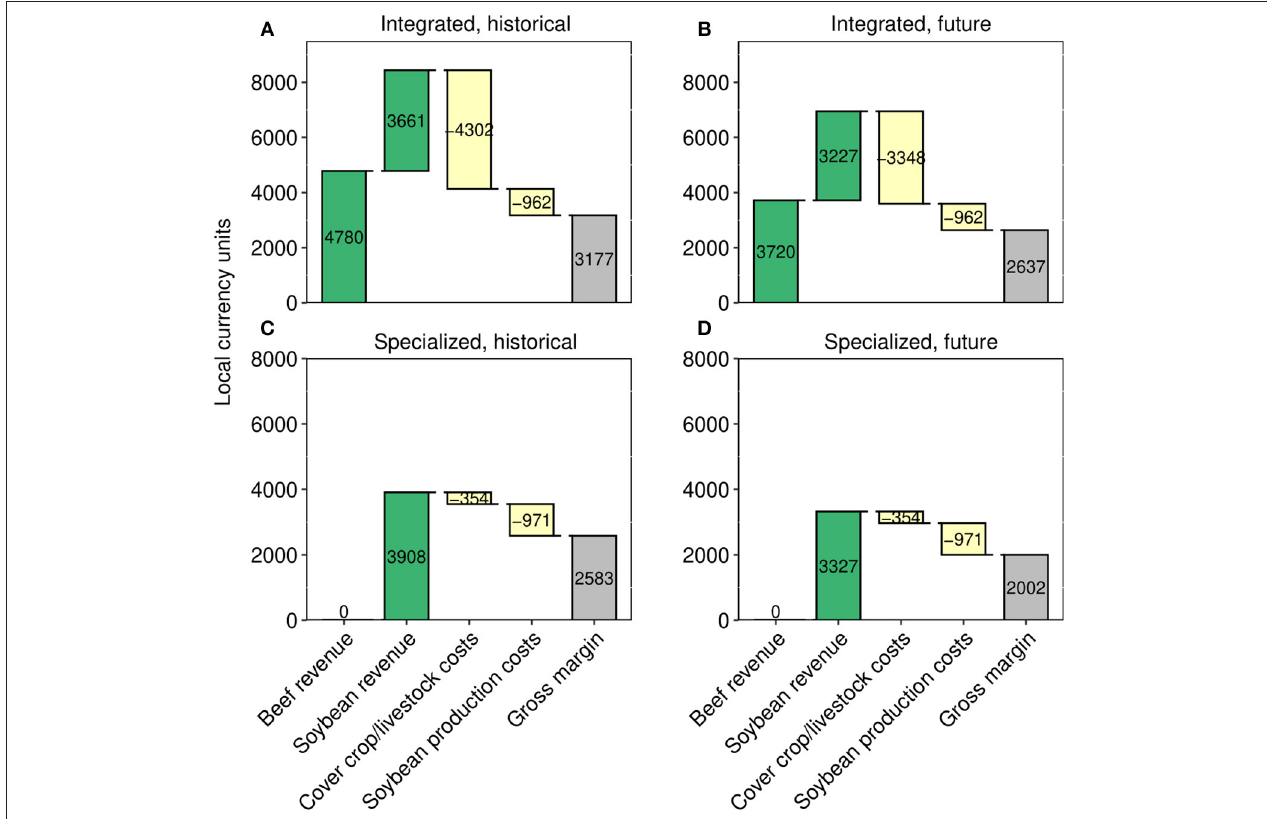
FIGURE 3 | Contributions of soybean and livestock revenues and production costs to gross margins for integrated (grazed cover crop; A , B ) and specialized (ungrazed cover crop; C , D ) system under historical ( A , C ; 1961–2017) and future ( B , D ; 2020–2060) climate scenarios.